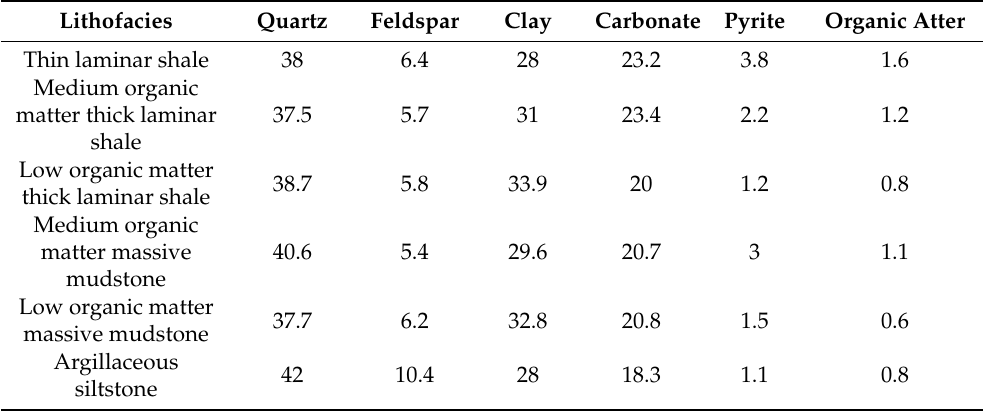
Table 2. Statistical table of shale facies mineral composition and organic matter content in Es3 member (unit: mass